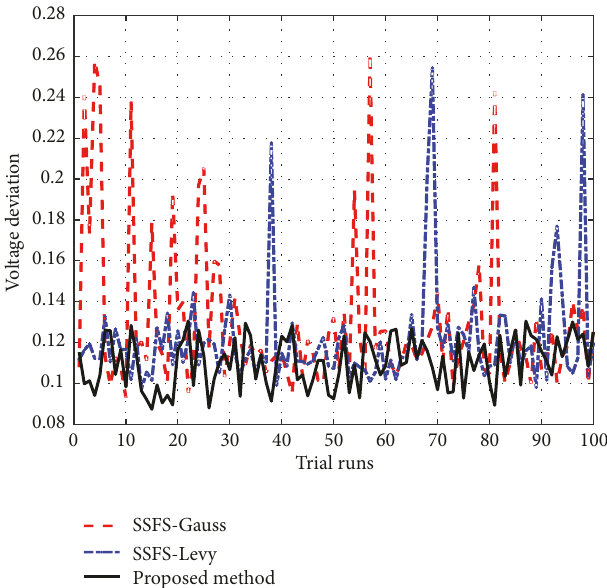
Figure 5: Comparisons of 100 runs for voltage deviation objective of IEEE 30-bus system obtained by three